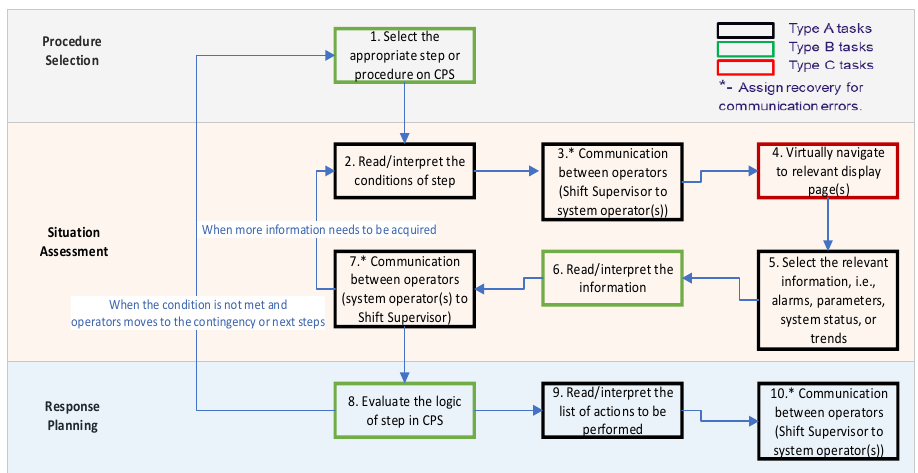
Figure 6. Diagnosis micro-tasks in the APRMCR.